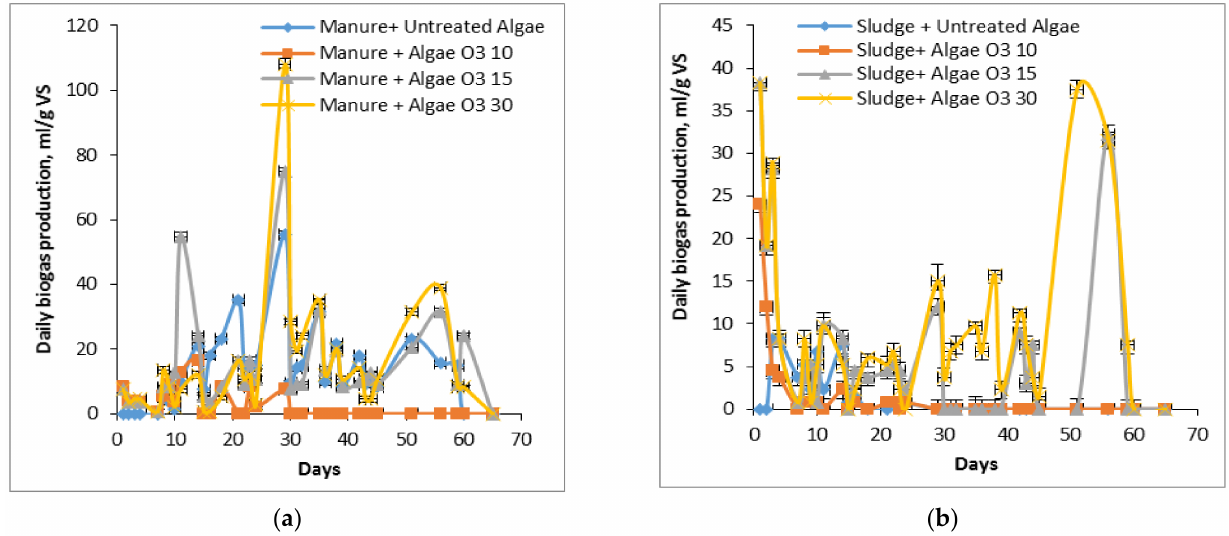
Figure 6. Average production of daily biogas using ( a ) Manure and ( b )